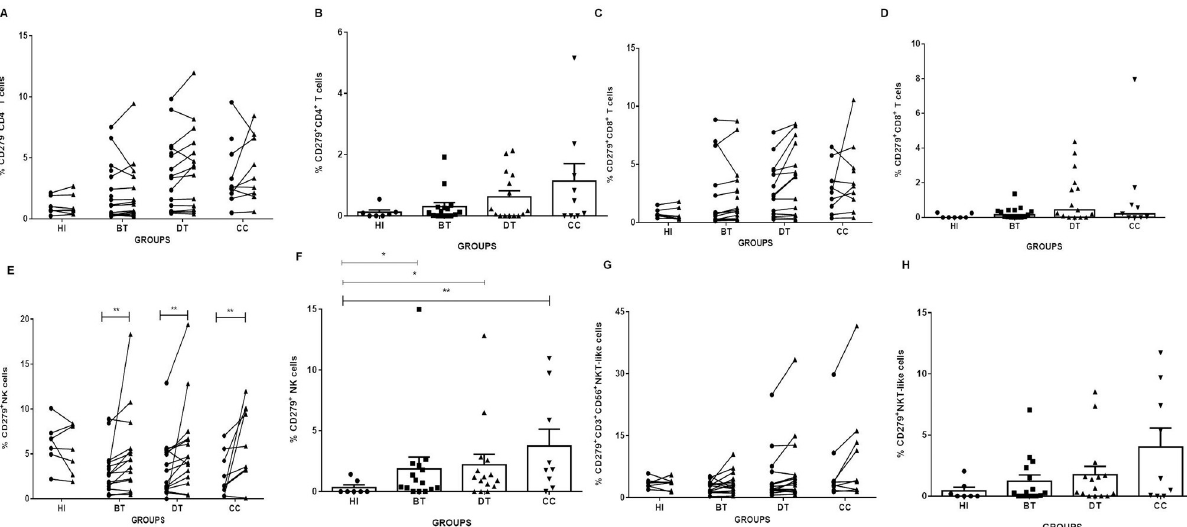
Fig 6. L . braziliensis antigens induce increase CD279 + NK cells in cell cultures from BT, DT and CC patients. Paired–analyses graphics show frequencies of ( A ) CD279 + CD4 + T; (C) CD279 + CD8 + T; (E) CD279 + NK; and (G) CD279 + CD3 + CD56 + NKT cells from before treatment (BT; n = 15); during treatment (DT; n = 15); clinical cure (CC; n = 9) patients. HI (n = 7) represents cell cultures from healthy individuals. Solid lines connect the results of non-stimulated (NS) ( ● ) and stimulated with L . braziliensis antigens ( Lb AgS) ( ▲ ) cell cultures for the same individual. Statistical analyses were performed by nonparametric Wilcoxon matched pairs test. Results between NS ( ● ) and Lb AgS ( ▲ ) cell cultures were considered significant with P � 0.05. � (P � 0.05); �� (P � 0.01). Column graphs B , D , F and H represent the mean ± SEM of frequencies of (B) CD279 + CD4 + T; (D) CD279 + CD8 + T; (F) CD279 + NK; and (H) CD279 + CD3 + CD56 + NKT in Lb Ag-stimulated ( Lb AgS) minus non-stimulated (NS) cell cultures from BT (n = 15); DT (n = 15); CC (n = 9) and HI (n = 7) groups. Statistical analyses were performed by nonparametric Mann-Whitney test. Results were considered significant with P � 0.05 comparing to HI. � (P � 0.05); �� (P � 0.01).